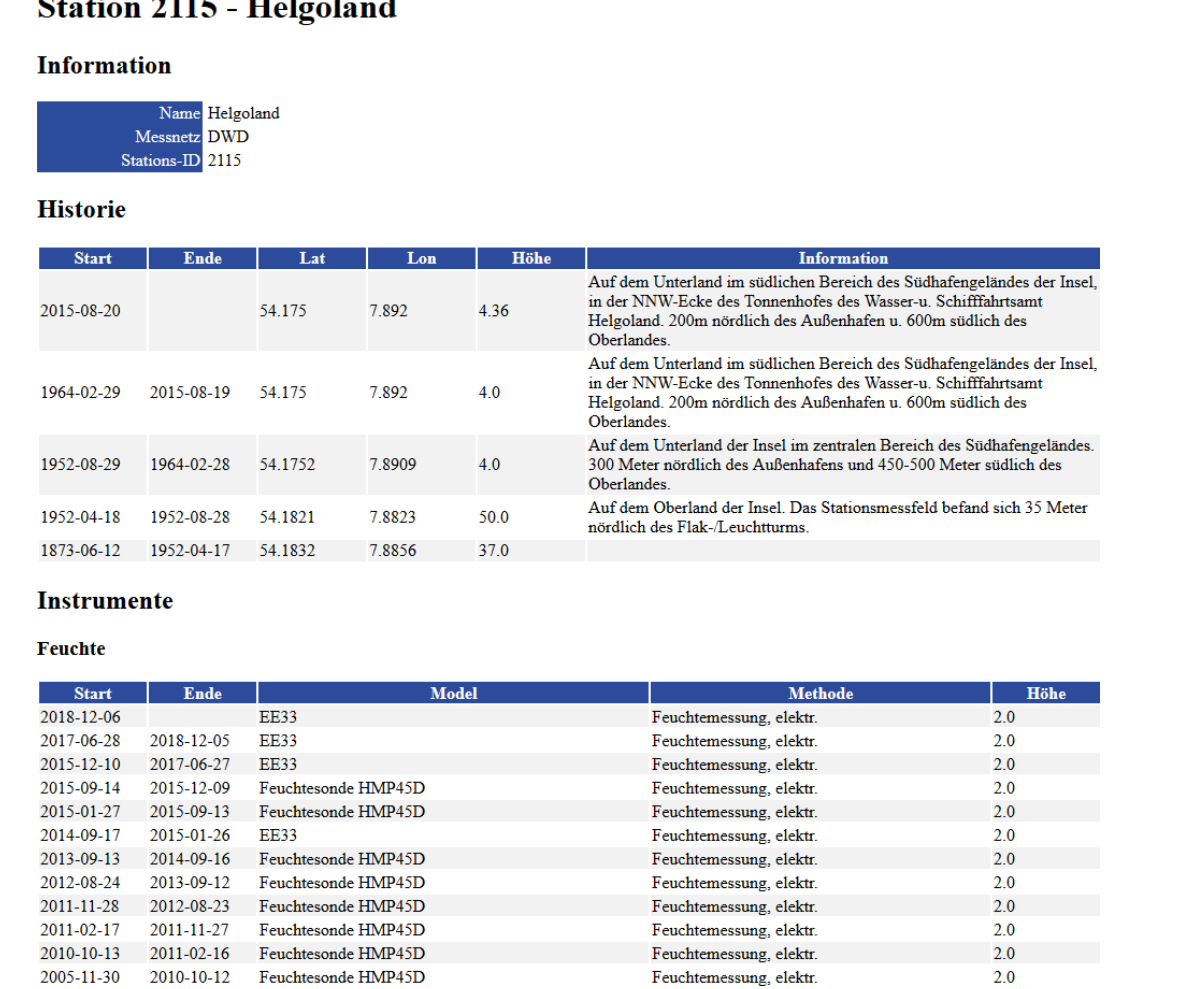
Figure 6. Excerpt from the detailed metadata of one station (Helgoland) (Source: Deutscher Wetterdienst).